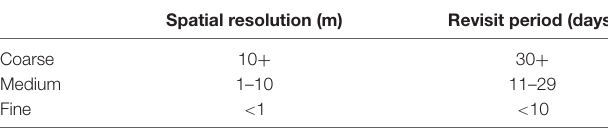
TABLE 1 | Definitions for “coarse,” “medium,” and “fine” spatial resolutions and revisit periods used in this